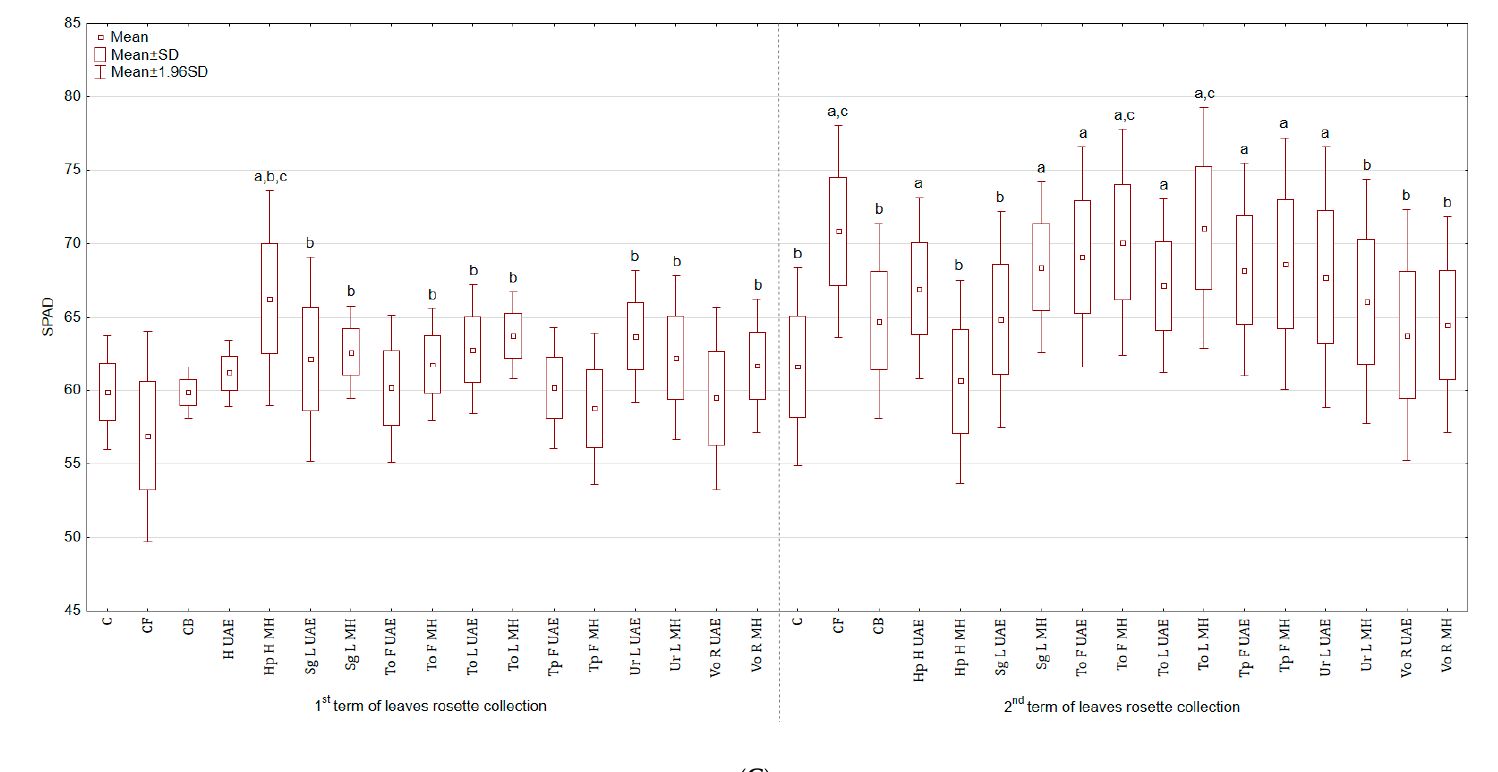
Figure 2. ( A ) . Effect of the foliar application of botanical extracts on the chlorophyll a + b content of celeriac leaves (N = 4). ( B ) Effect of the foliar application of botanical extracts on the carotenoids content of celeriac leaves (N = 4). ( C ) Effect of the foliar application of botanical extracts on the SPAD values of celeriac leaves (N = 10). (a) Statistically significant differences ( p < 0.05) between the control group (C) and extracts. (b) Statistically significant differences ( p < 0.05) between water formulation (CF) and extracts. (c) Statistically significant differences ( p < 0.05) between commercial biostimulant (CB) and extracts. 1st term of leaves rosette collection—samples taken for analyses 7 days after the second spraying. 2nd term of leaves rosette collection—samples taken for analyses after harvesting. Abbreviations: UAE, ultrasound assisted extraction; MH, mechanical homogenisation; Hp H, Hypericum perforatum L. (St. John’s wort, herb); Sg L, Solidago gigantea Ait. (giant goldenrod, leaf); To F, To L, Taraxacum officinale (L.) Weber ex F.H. Wigg (common dandelion, flower, leaf); Tp F, Trifolium pratense L. (red clover, flower); Ur L, Urtica dioica L. (nettle, leaf); Vo R, Valeriana officinalis L. (valerian, root).